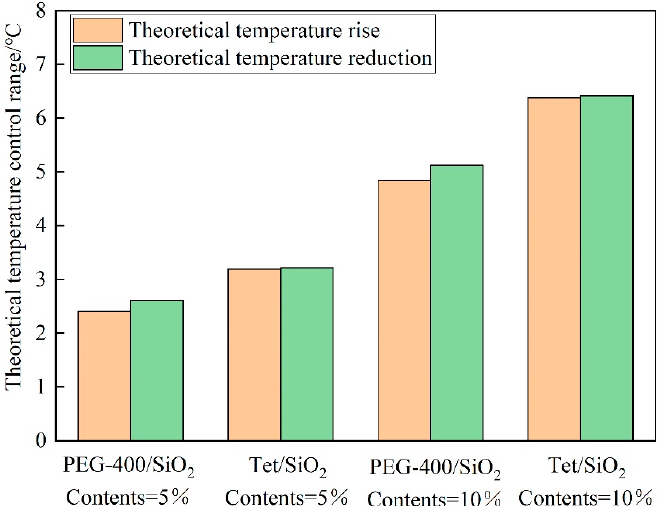
Figure 12. Theoretical temperature control range of PEG-400/SiO 2 and Tet/SiO 2 composite shaped PCM recycled aggregate pavement bricks.